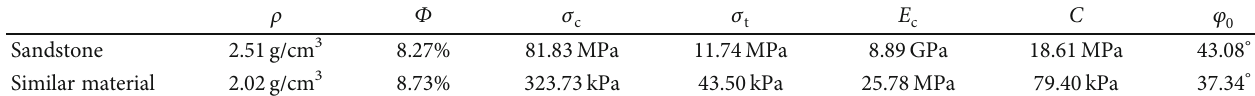
Table 1: Physical – mechanical properties of prototype and similar material.